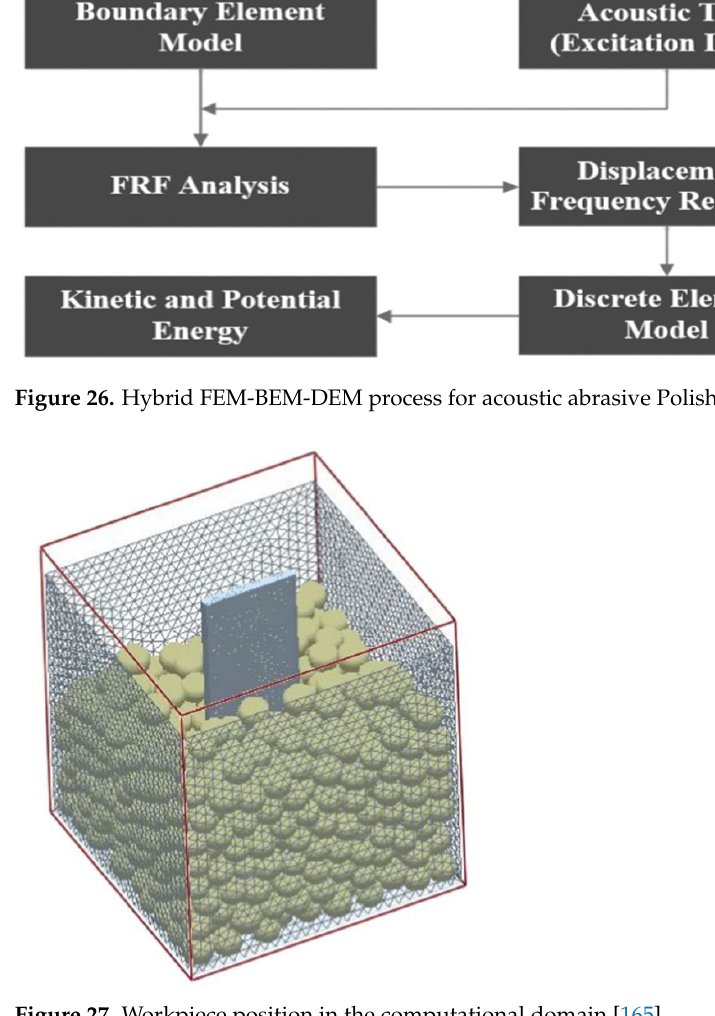
Figure 27. Workpiece position in the computational domain [165].